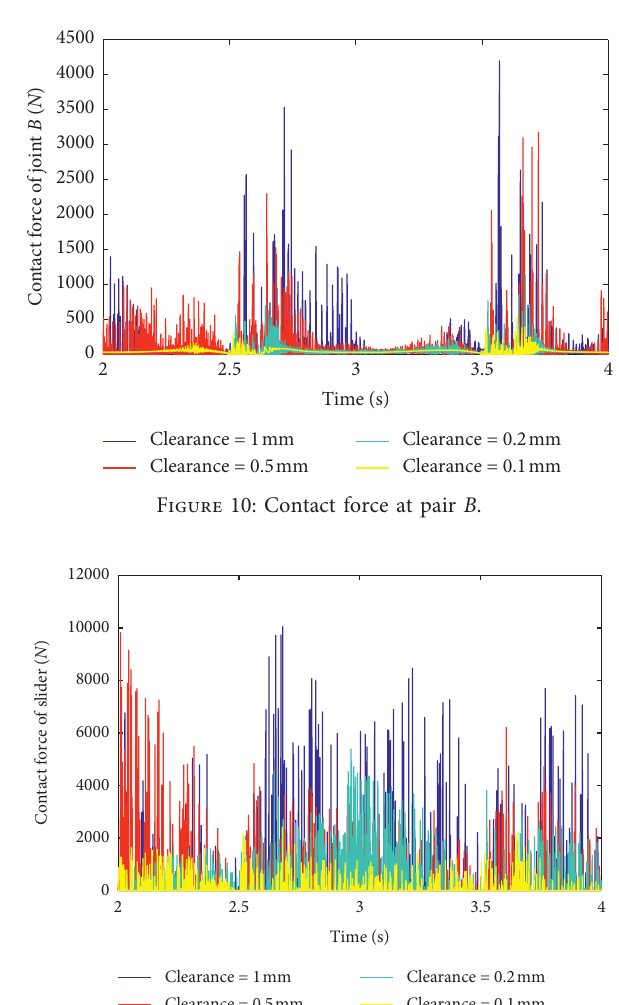
Figure 9: Contact force at pair A .